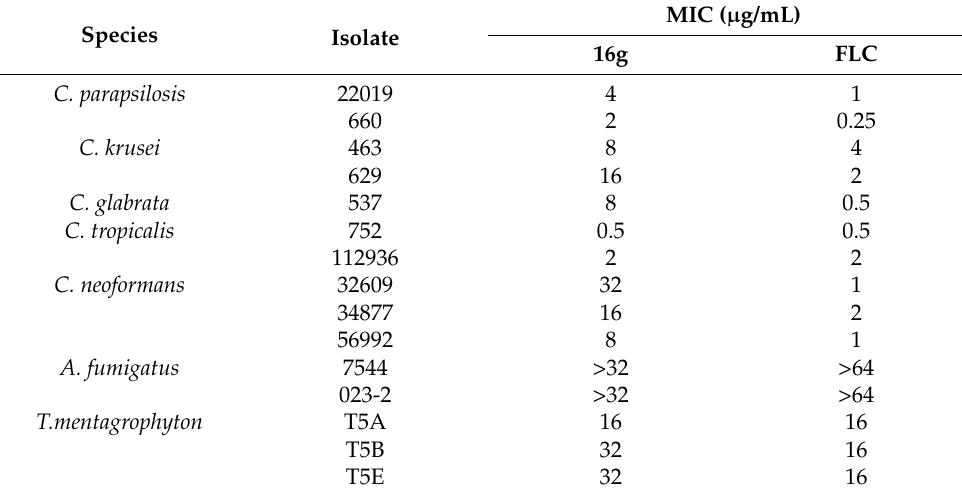
Table 4. In vitro antifungal activities of 16g and FLC.